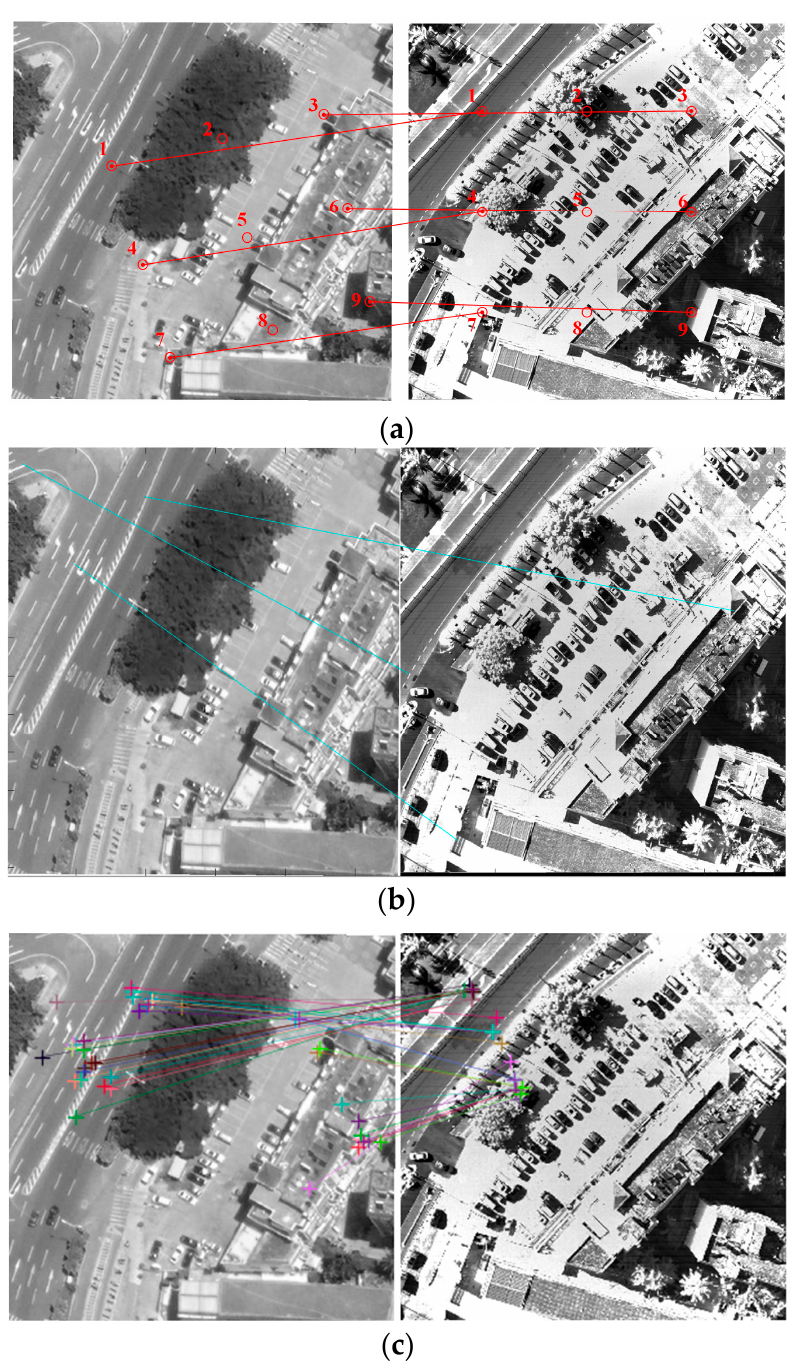
the case of heterologous image registration, SIFT-algorithm- and neural-network-based registration algorithms were used to register the two images in the experiment, and the results were compared with the GLI algorithm, as shown in Figure 12. The number in Figure 12a represents the selection order of registration points in the GLI algorithm, and the cross symbol in Figure 12c represents the position of feature points extracted by CNN.